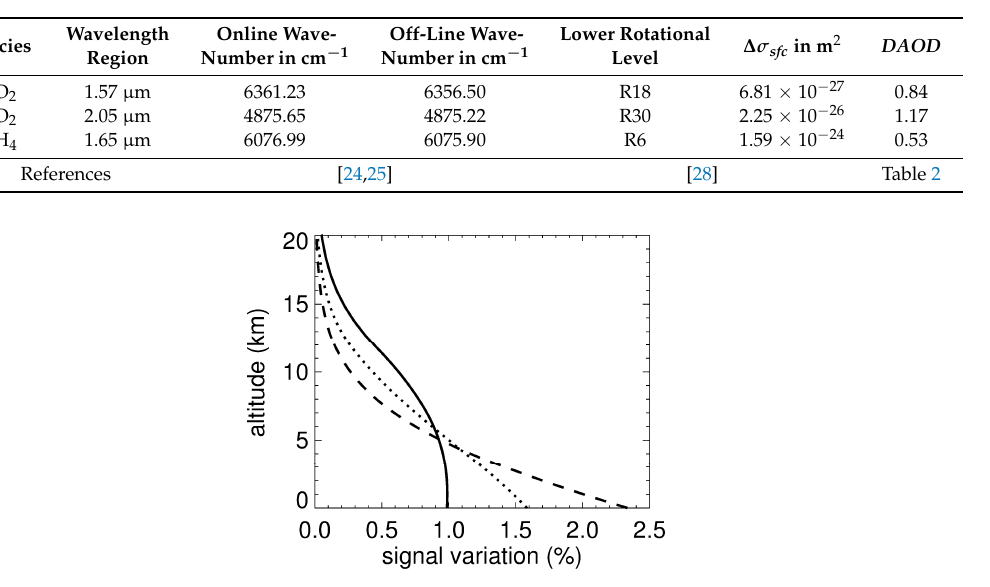
Figure 2. Relative IPDA signal variation as function of the altitude in which the total column CO 2 or CH 4 volume mixing ratio (vmr) is doubled within a 100-m layer, without changing the rest of the column. A wavenumber position more in the CO 2 absorption line wing (dashed; 2.05 µm) than close to the line center (solid; 1.57 µm) brings more variation and herewith sensitivity in the lower troposphere. Dotted: for CH 4 IPDA at 1.65 µm.